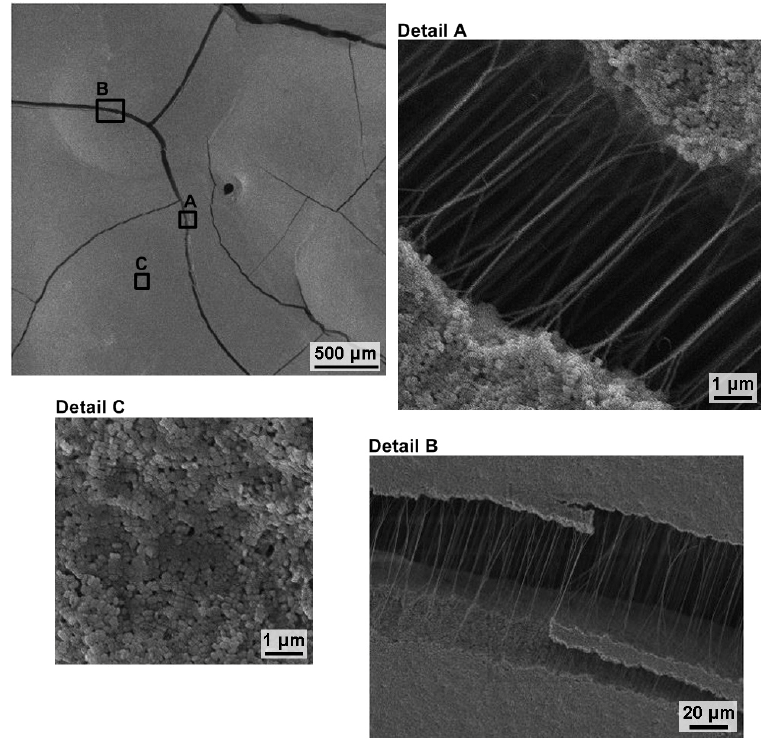
Figure 4. Image of the sample surface after Alfiflon 39 (SEM), details ( A , B ) provide a detailed view of the long PTFE fibers and in detail ( C ) there is only the surface Alfiflon 39.